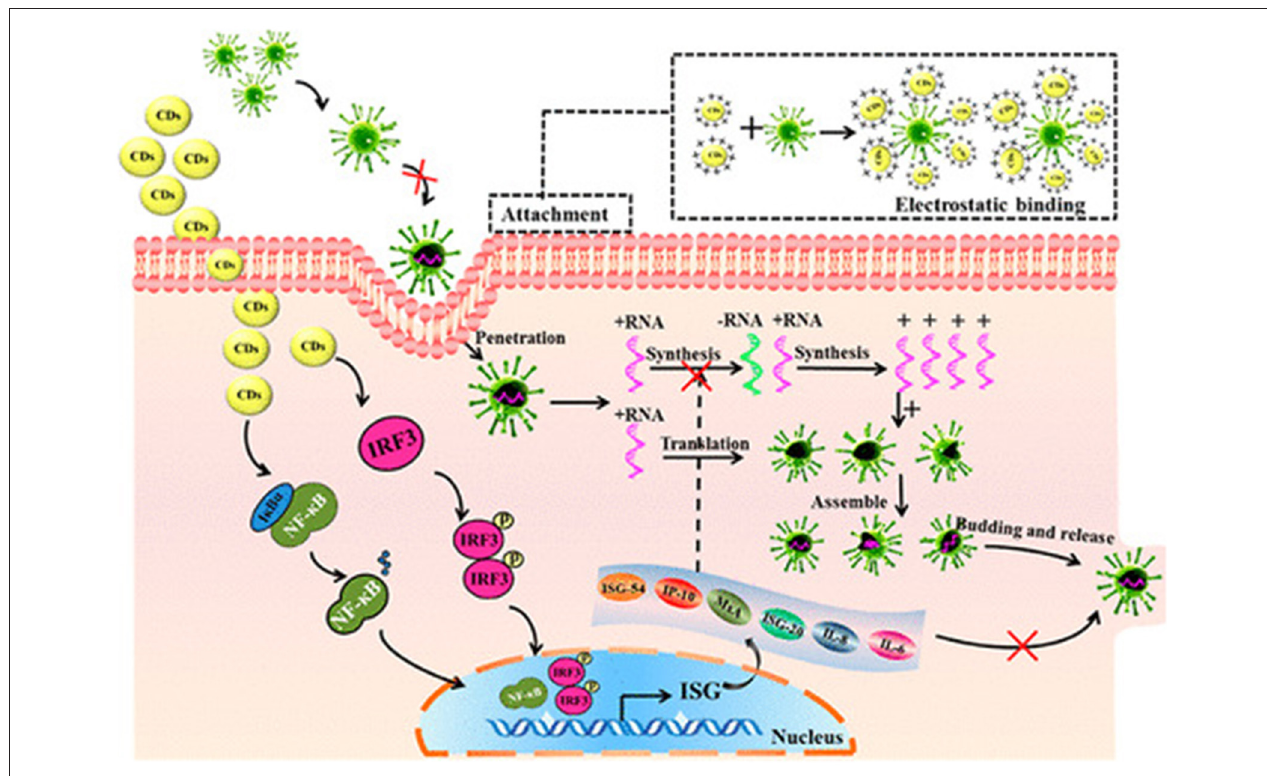
FIGURE 2 | Mechanism of viral inhibition of cationic curcumin carbon dots. Reprinted with permission from Ting et al. (2018). Copyright (2018) American Chemical Society.